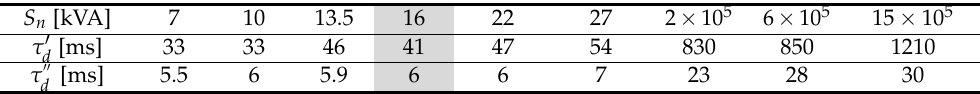
Table 3. The values of electromagnetic time constants for the sub-transient and transient states [23,24]. S n [kVA]